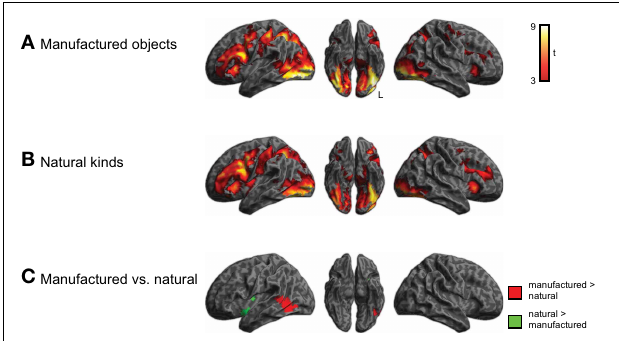
FIGURE 4 | Brain activity for judgments about manufactured objects and natural kinds, across all three groups of subjects (voxelwise p < 0 . 001, cluster-level corrected q < 0 . 05). (A) Activity for manufactured objects. (B) Activity for natural kinds. (C) Comparison of activity for manufactured objects and natural kinds. The category × group interaction was not significant.